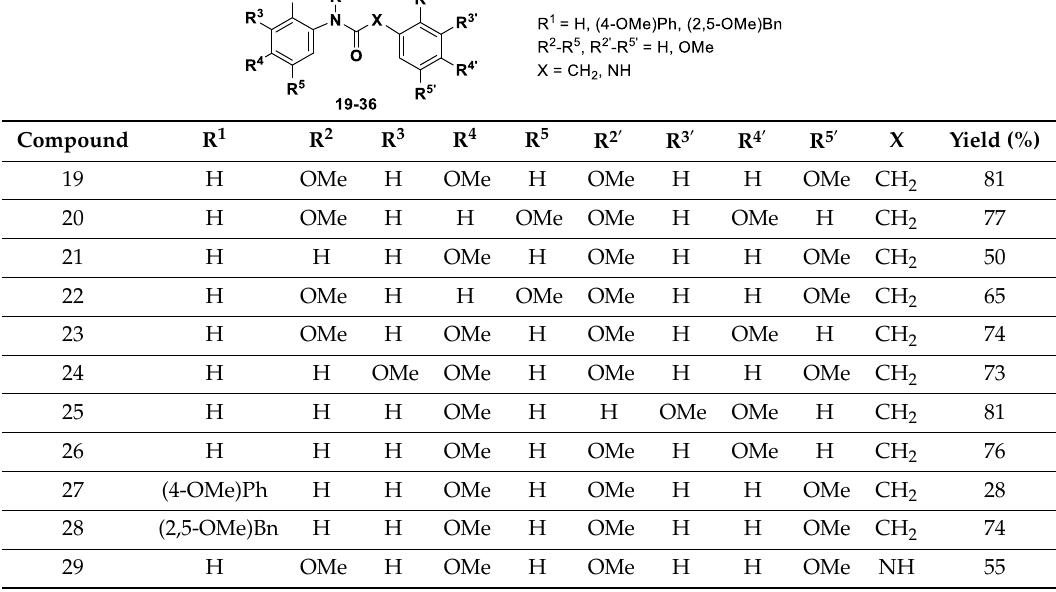
Table 2. Structures and yield of OMe precursors prepared, amides 19 to 28 and ureas 29 to 36 .